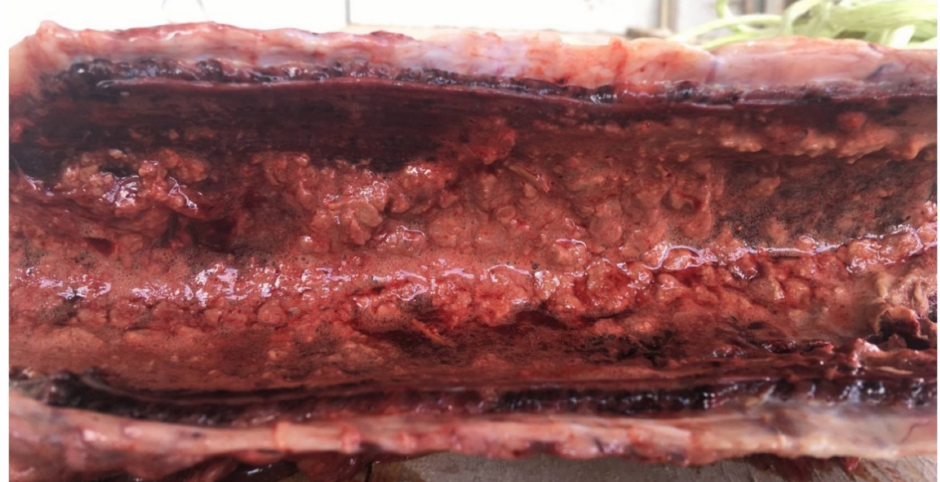
Figure 1. Tracheal mucosa. Severe, acute, diffuse fibrinonecrotic tracheitis. In the cut section, the tracheal wall appears strongly hyperemic, while the mucosa is diffusely covered by fibrinous–necrotic “bran-like” debris.